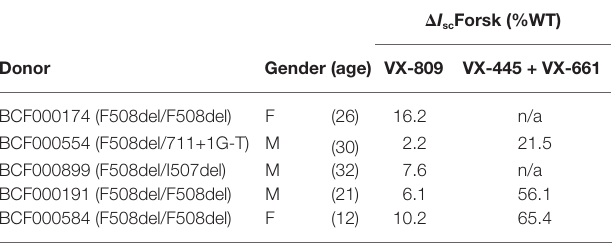
TABLE 1 | Short circuit current responses to forskolin ( Δ I sc Forsk) for well-differentiated primary bronchial epithelial cells used in this study, after treatment with correctors. Δ I sc Forsk